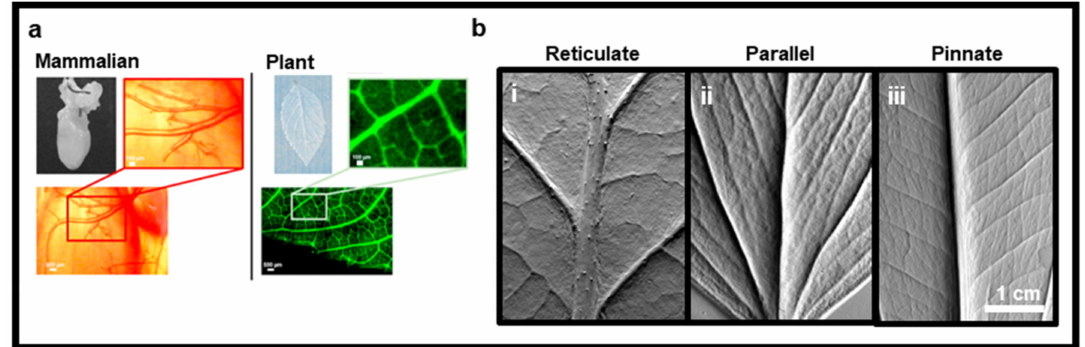
Figure 5. The vein network of vascular plant tissues, such as spinach leaves, tapers, and branches similar to that found in a mammalian network ( a ). Reproduced from Gershlak et al. [34]. Vascular networks of ( b-i ) spinach, ( b-ii ) lemon, and ( b-iii ) amazon sword plant leaves display various tapered patterns, including reticulate, parallel, or pinnate designs, respectively. Topographical images were obtained by authors for illustrative purposes for this review using a tactile sensor pad imaged with a GelSight, Inc., Benchtop